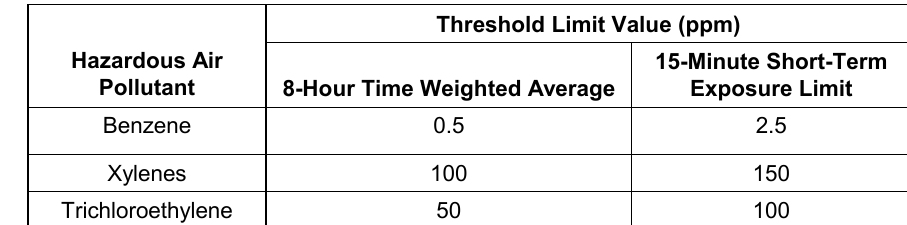
Table 8. Threshold Limit Values for several hazardous air pollutants [